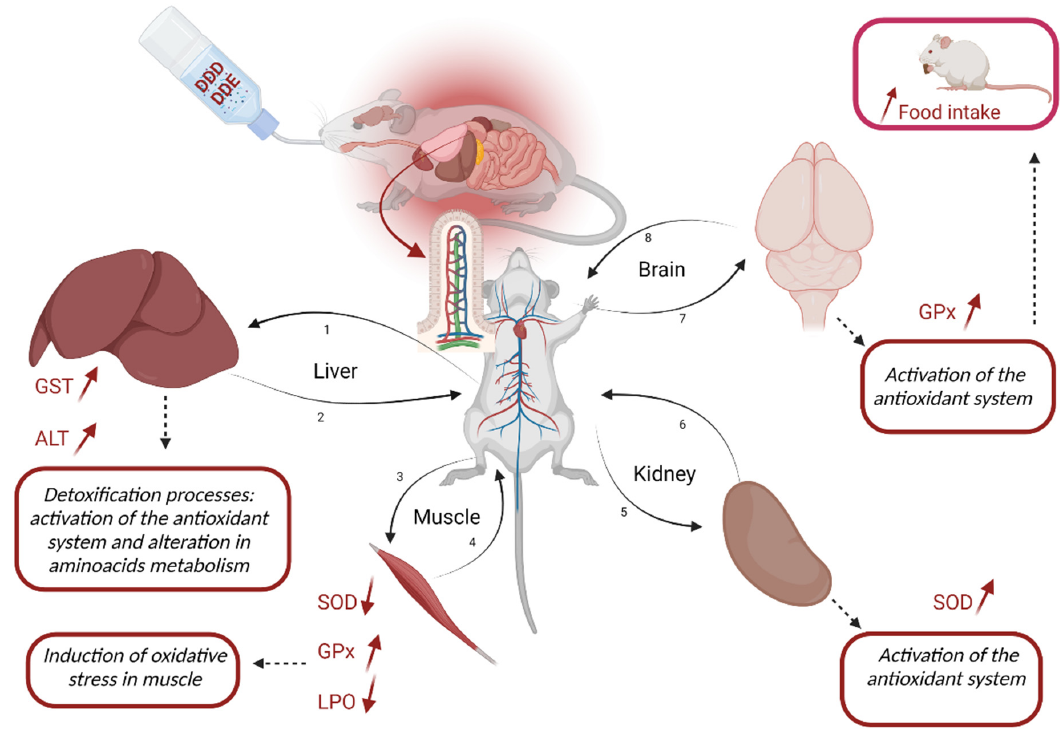
Figure 4. Overview of the results for Wistar rats chronically exposed to trace concentrations of DDD and DDE (0.002 mg.L − 1 and 0.005 mg.L − 1 , respectively). The most signi fi cant absorption of DDD and